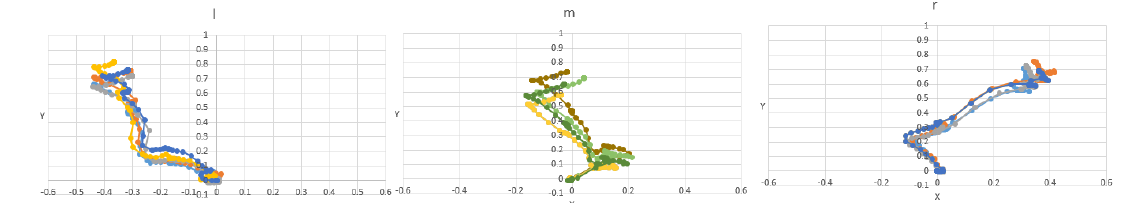
Table 3. Rotation angle of each individual motor. Figure 13. Snaky movement trajectories. Figure 13. Snaky movement trajectories.